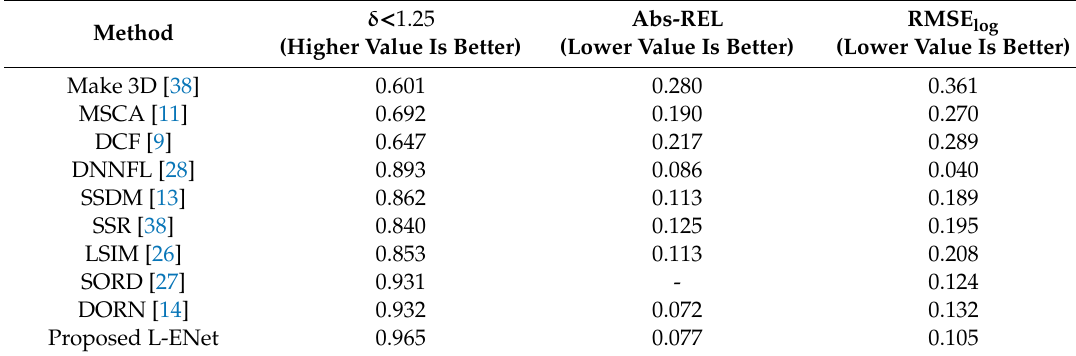
Table 2. Evaluation results on KITTI dataset.